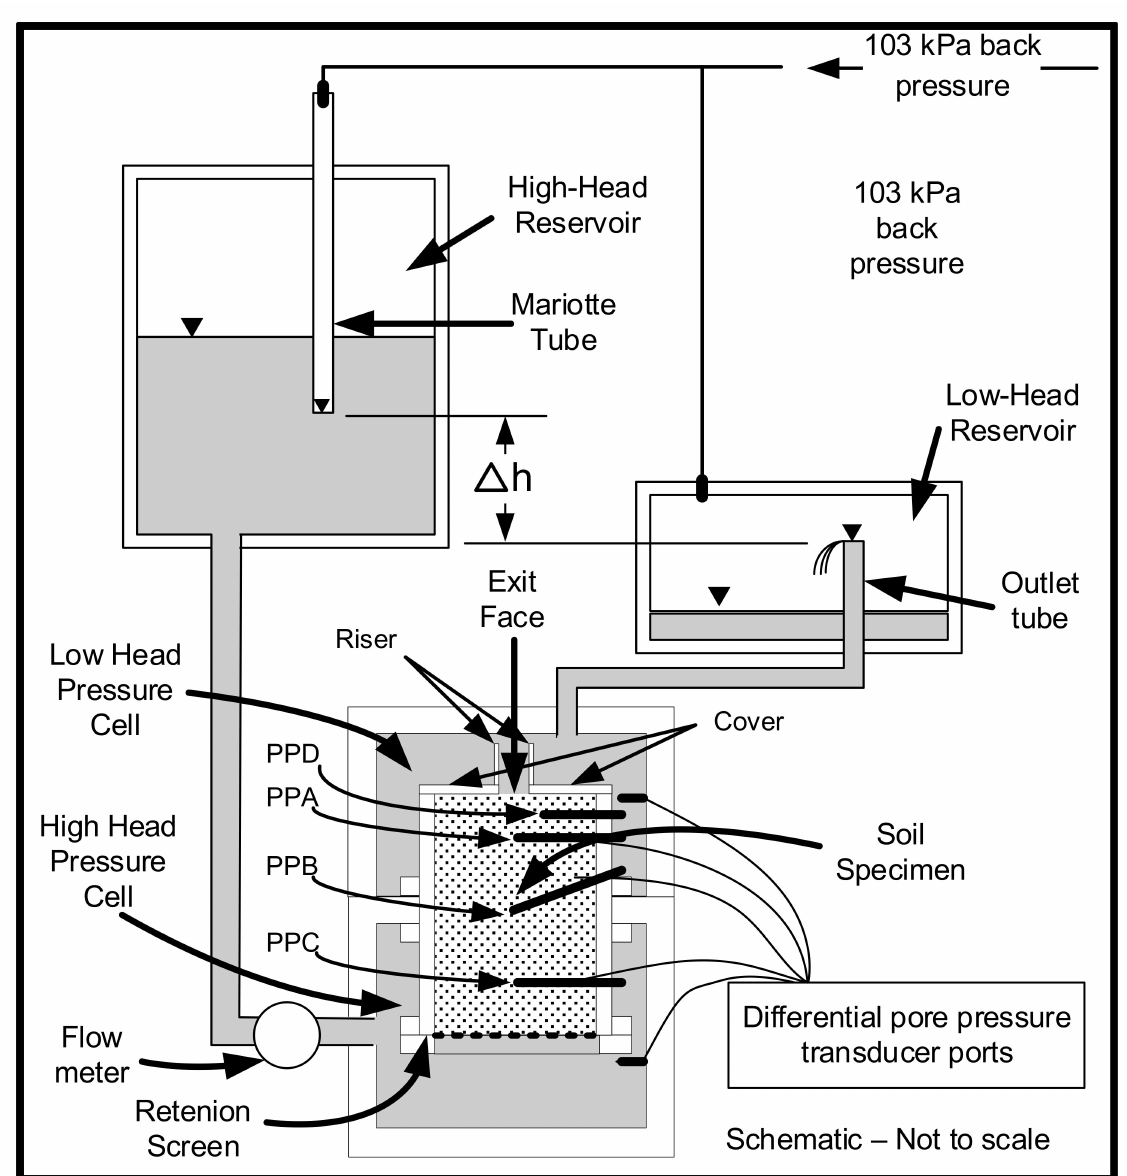
Figure 2. Schematic illustration of the testing apparatus (Adapted from Peng et al.